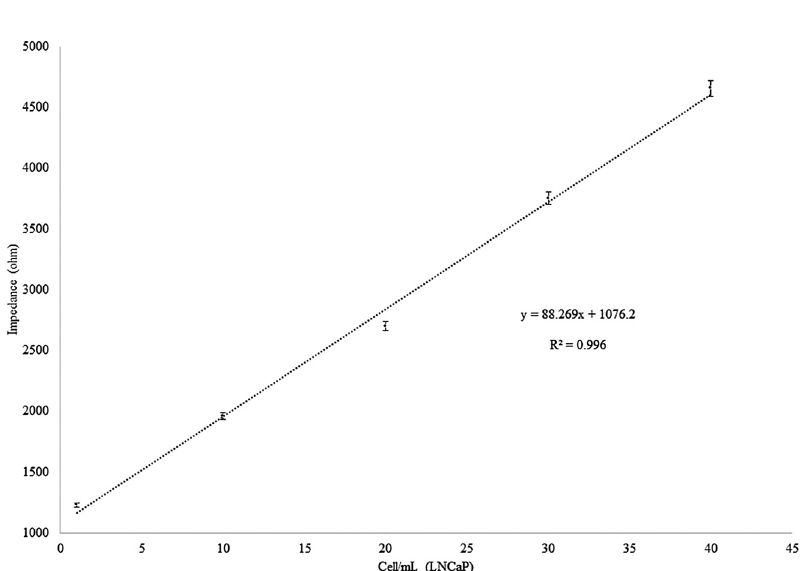
Figure 4: EIS representation of the standard graph of the LNCaP biosensor between 1 and 40 cells/mL.